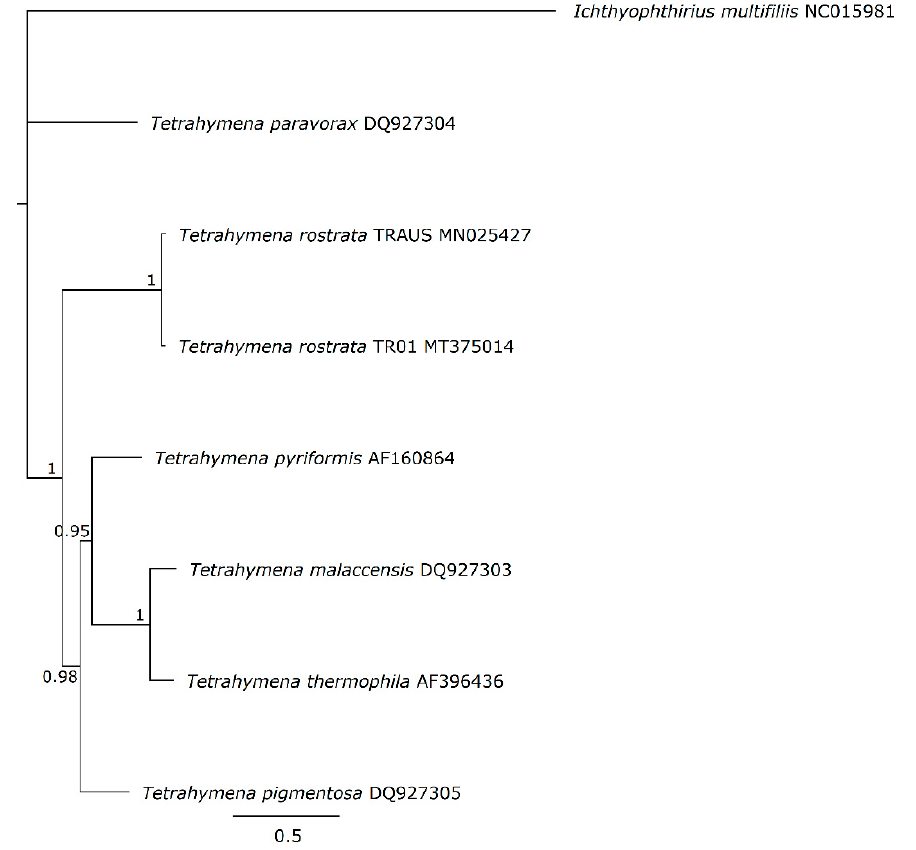
Figure 3. MrBayes tree of the translated, concatenated amino acid coding regions of the mt genomes of T. rostrata TRAUS, TR01 and other Tetrahymena species. The MrBayes tree was built in Geneious Prime v.1.2 using a 1,100,000-generation chain length and a 1,000,000-generation burn-in with Ichthyophthirius multifiliis as an out group. Posterior probability values are shown to indicate branch support.